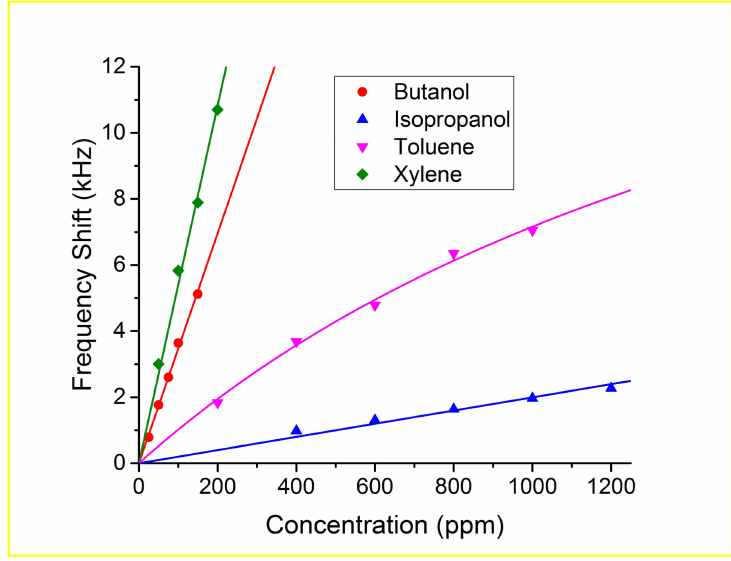
Figure 7. Response of the Love sensor for different